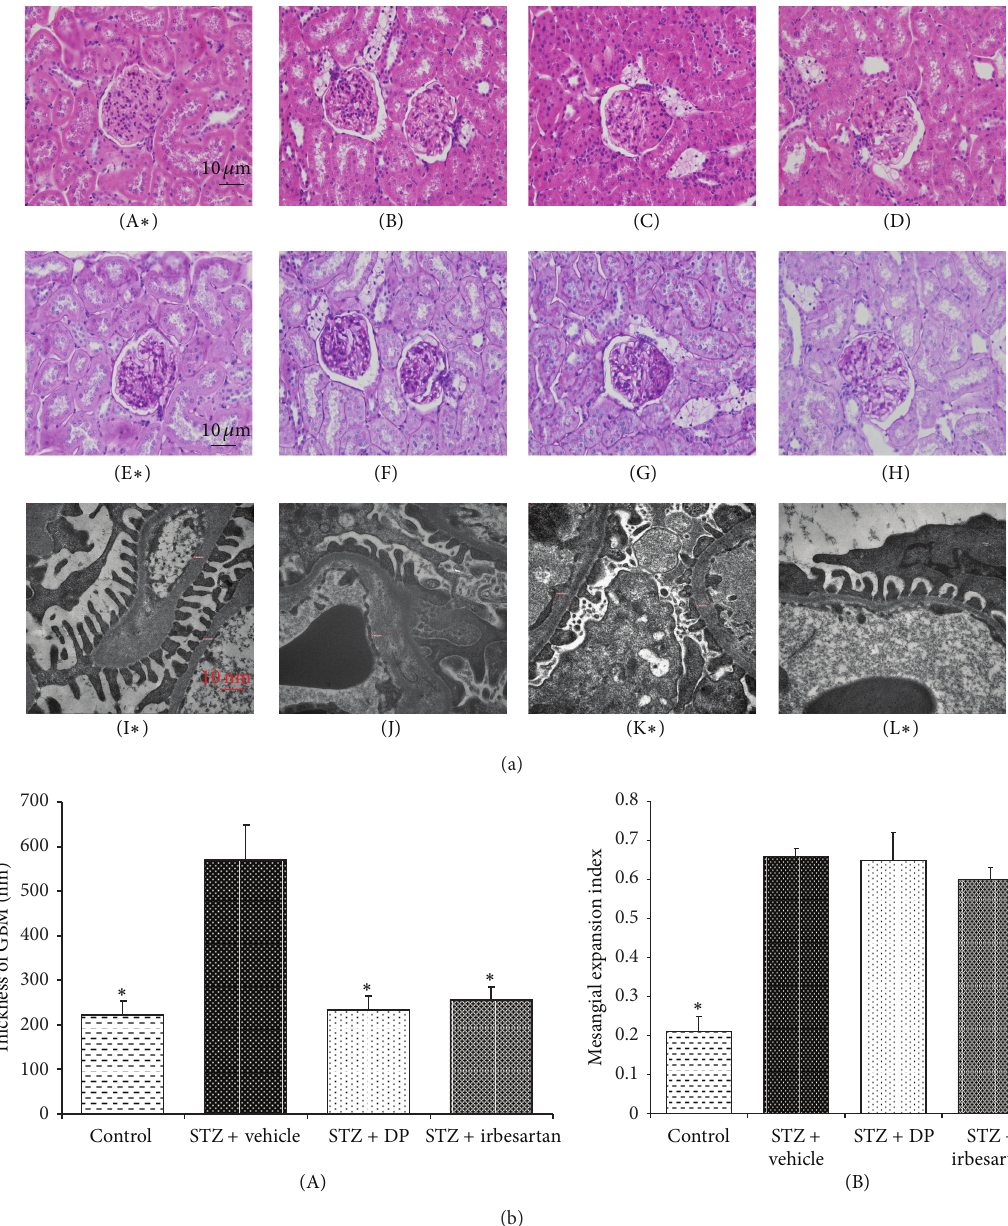
Figure 1: Effect of DP and irbesartan treatments on the renal pathological changes. (a) Renal pathological changes of mesangial expansion were examined by histological staining (HE and PAS), and thickness of the GBM was determined by electron microscopy, as described in the materials and methods section. (A)(E)(I) Normal renal cortex in the control group. (B)(F)(J) STZ + vehicle group. (C)(G)(K) STZ + DP (500mg/(kg ⋅ day) group. (D)(H)(L) STZ + irbesartan (50mg/(kg ⋅ day)) group. (b) Thickness of the GBM (A) and mesangial expansion